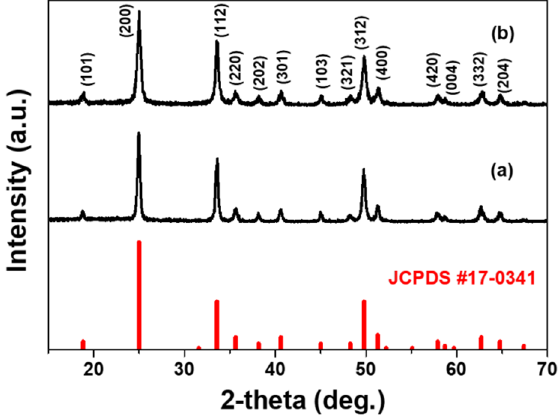
Figure 1. XRD patterns of the hydrothermally grown YVO 4 :Eu 3 + nanoparticles using the precursor solutions at (a) pH = 7 and (b) pH = 10.